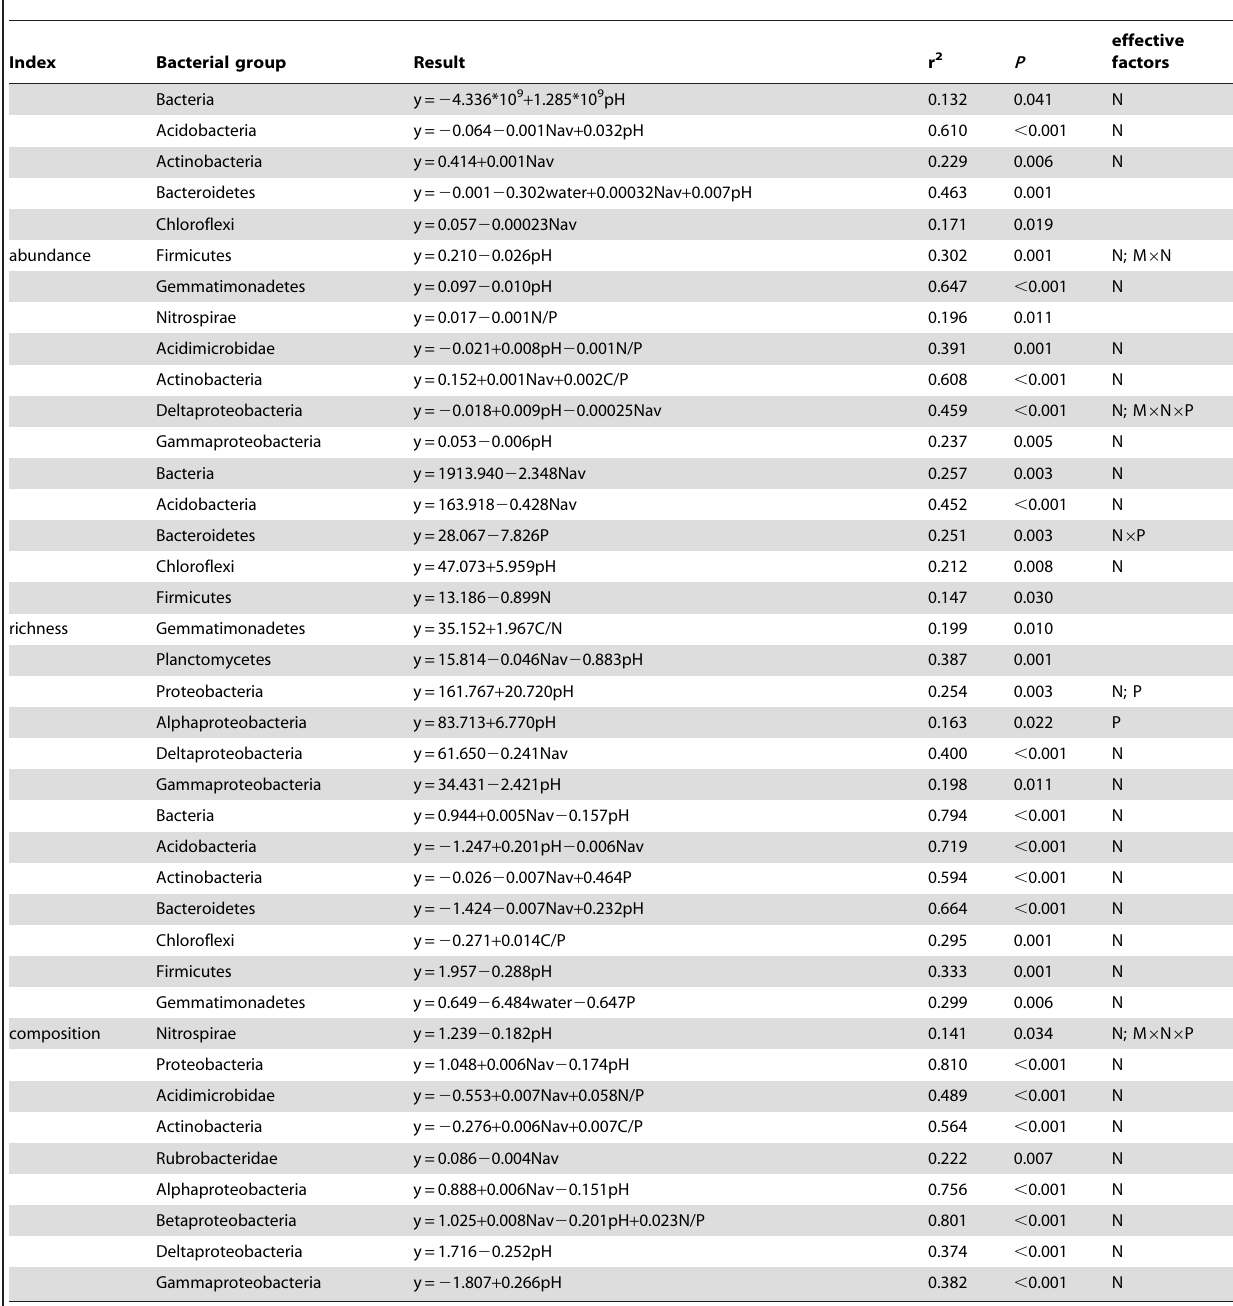
Table 2. Variables responsible for the changes in abundance, richness, and composition of various bacterial